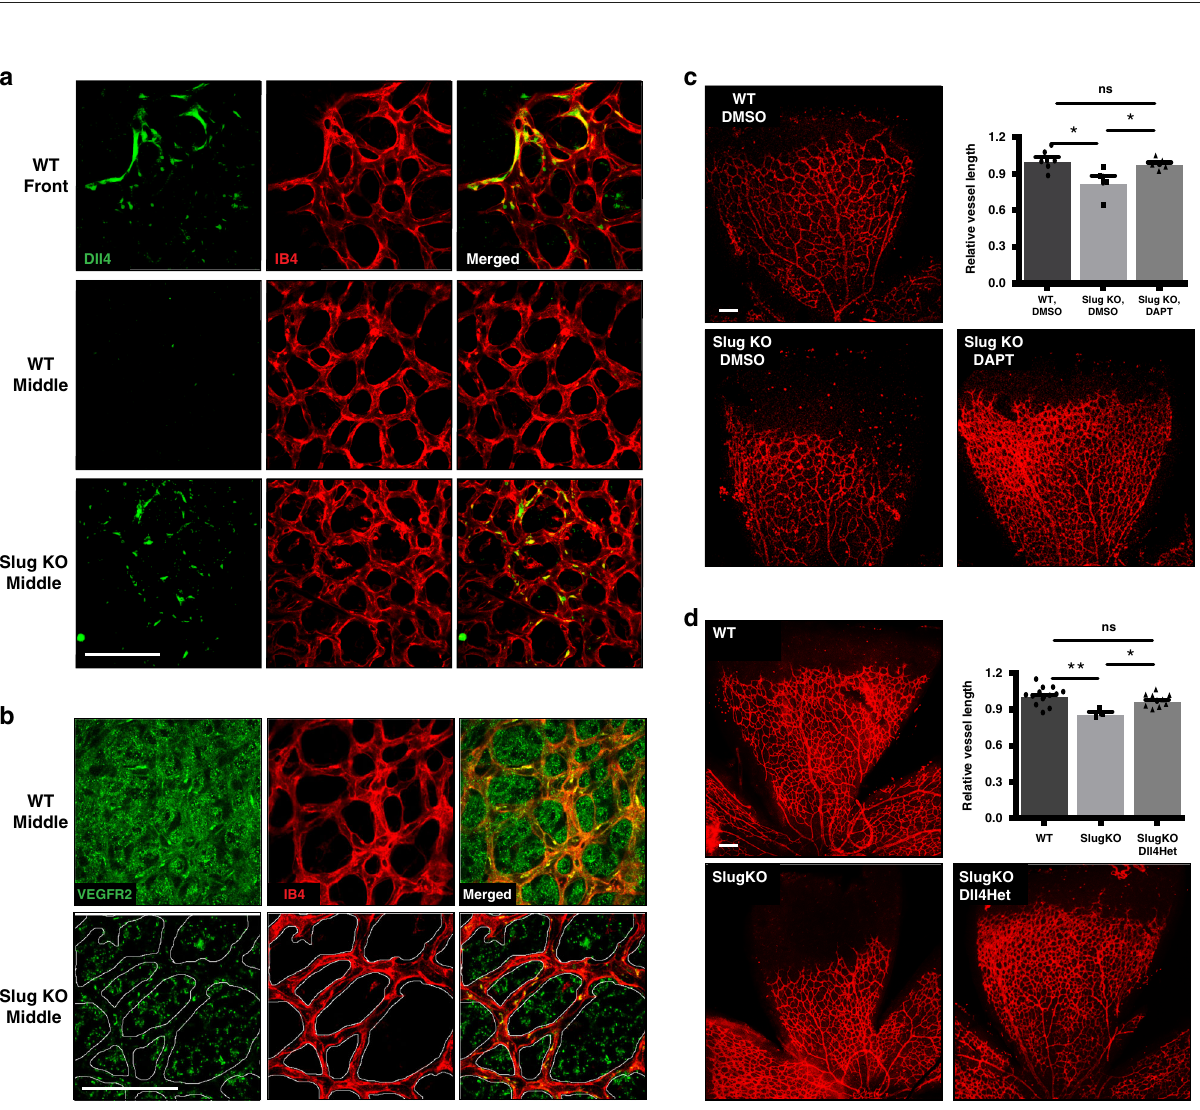
Fig. 6 Notch inhibition rescues delayed vascular expansion in SlugKO mouse retina. a Immuno fl uorescent staining showing localization of Dll4 expression at the angiogenic front and the middle of the network in WT and SlugKO mice, respectively. Scale bar: 100 µ m. b Immuno fl uorescent staining showing reduced VEGFR2 expression in SlugKO retinas compared to the WT. Scale bar: 100 µ m. c IB4 staining of P5 retinas from WT and SlugKO mice treated with DMSO control or DAPT via subcutaneous injection. Scale bar: 100 µ m. Quanti fi cation shown in top right corner (WT-DMSO n = 6 animals, SlugKO-DMSO n = 4 animals, p = 0.03. SlugKO-DAPT n = 5 animals, p = 0.045). d IB4 staining of P5 retinas from WT, SlugKO and SlugKO/Dll4Het. Quanti fi cation shown in top right corner (WT n = 13 animals, SlugKO n = 3 animals, p = 0.007. SlugKO/Dll4Het n = 9 animals, p = 0.014). Scale bar: 100 µ m. Data represent mean ± SEM. Two-tailed unpaired equal-variance t -test. * p < 0.05, ** p < 0.01, *** p < 0.005. Source data are provided as a Source Data fi